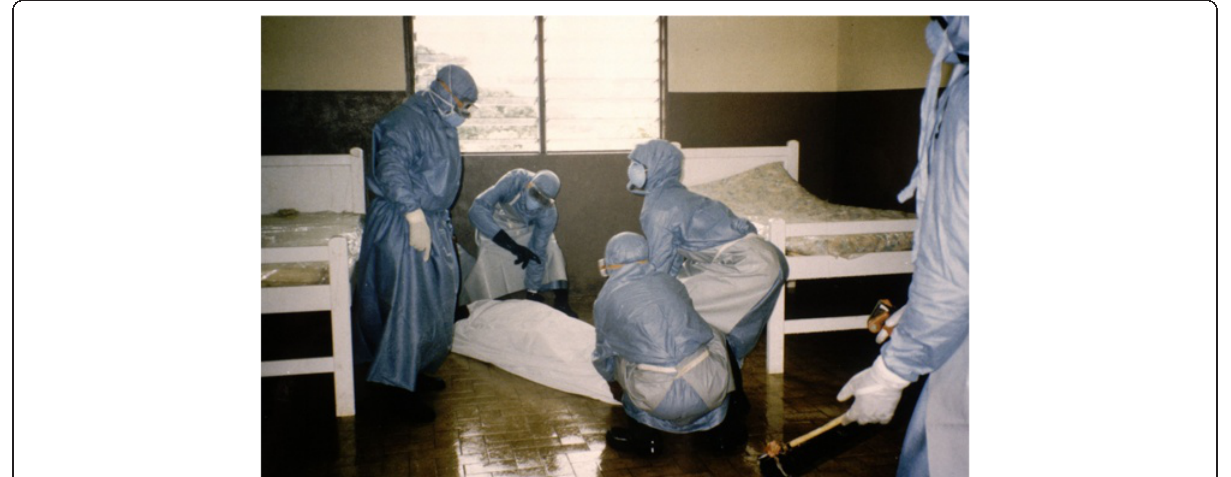
Figure 8 Wrapping of the body in a mortuary sac (photo by Jean-Paul Gonzalez,